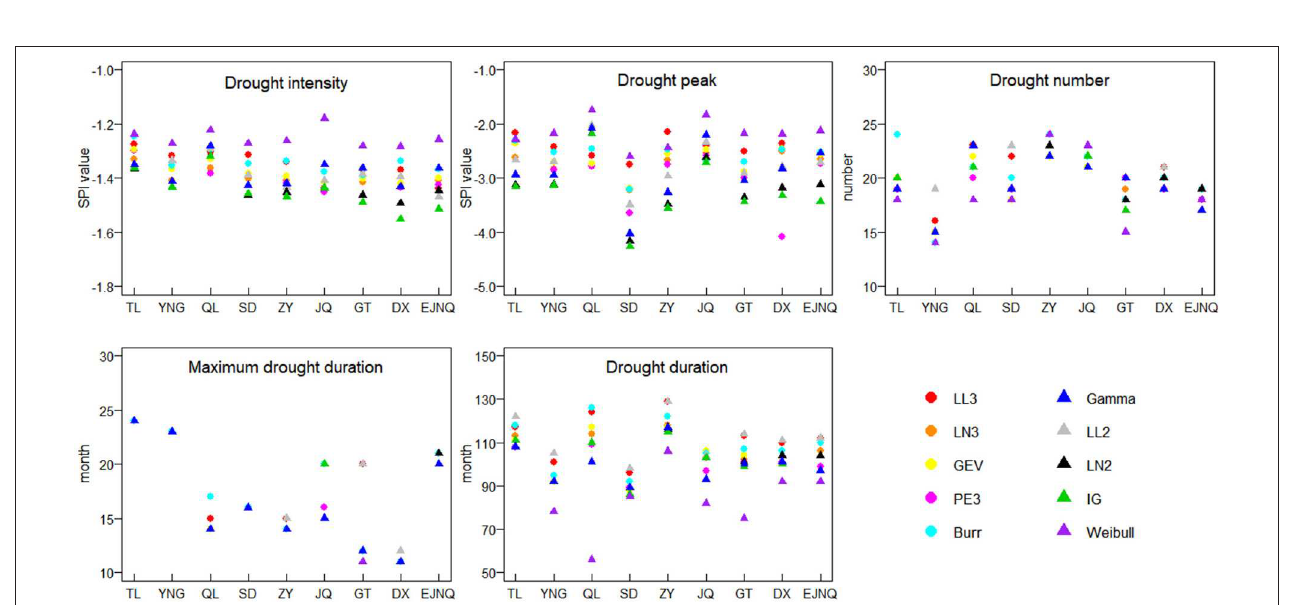
FIGURE 5 | Drought characteristics derived from different probability distributions (the abbreviations are the same as in Figure 3 ).